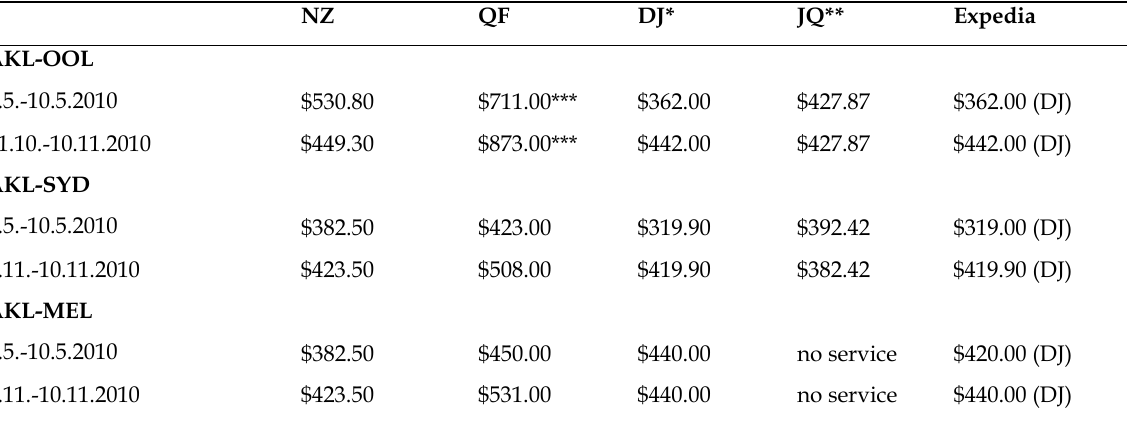
Table 8. Fare Comparison for Selected Trans-Tasman Routes/Dates (in $NZ as per 29.03.2010)